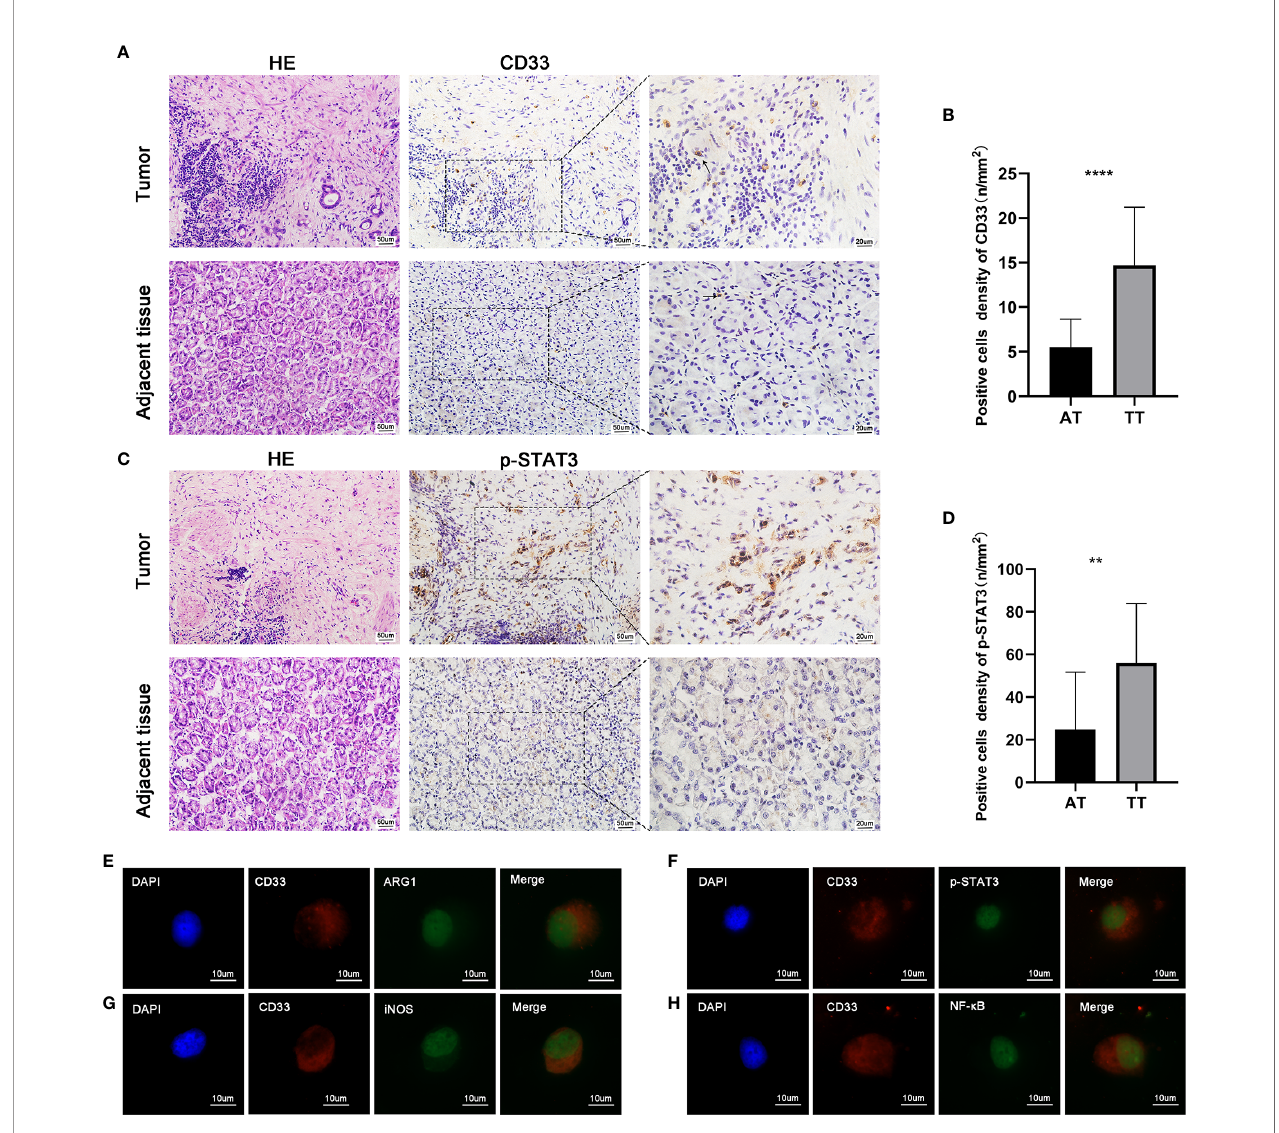
FIGURE 5 | The paraf fi n-embedded AEG tissues were collected for p-STAT3 and CD33 staining. Histopathological appearance of AEG tumor tissues and adjacent non-tumorous tissues and immunohistochemical representative images of CD33+ (MDSCs) (A) , p-STAT3 (C) in tumor tissue and adjacent non-tumorous tissues. There was weak or negative expression of p-STAT3 in adjacent normal tissues. However, there was strong expression of p-STAT3 in AEG tissues mainly localized in the nuclei of tumor epithelial cells and stroma cells. Quantitative analysis of CD33 (B) and p-STAT3 (D) positive staining in AEG and adjacent normal tissues. Representative double immuno fl uorescence pictures of the co-localization of CD33 (red) and AEG1 (green) (E) . Representative double immuno fl uorescence pictures of the co-localization of CD33 (red) and p-STAT3 (green) (F) . Representative double immuno fl uorescence pictures of the co-localization of CD33 (red) and iNOS (green) (G) . Representative double immuno fl uorescence pictures of the co-localization of CD33 (red) and NF- k B (green) (H) . Data depict the mean ± SEM. The p values are represented as follows: (**p < 0.01; ****p < 0.0001). Black arrows showed CD33 + cells. 20× magni fi cation, scale bar = 50 um; 40× magni fi cation, scale bar = 20 um; 100× magni fi cation, scale bar = 10 um, applicable to all